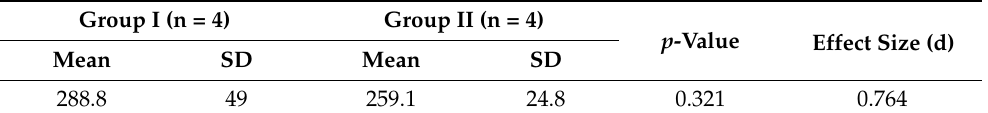
Table 1. Descriptive statistics and results of Student’s t -test for comparison between accuracy (RMS) of the two groups.